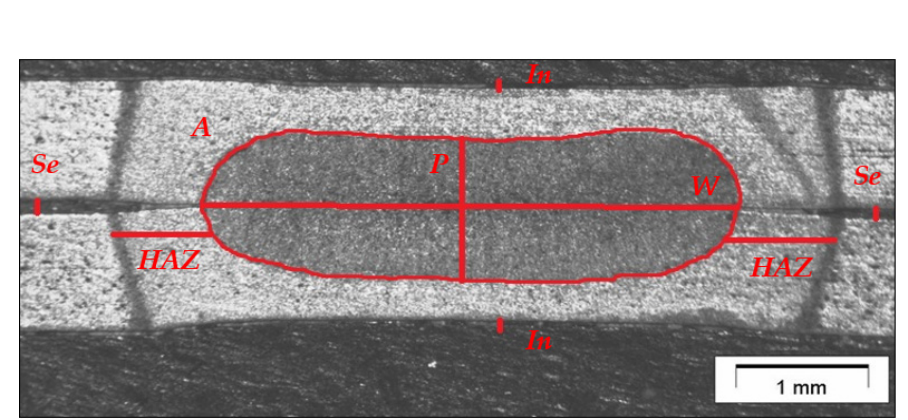
Figure 12. Visual representation of the measured variables.